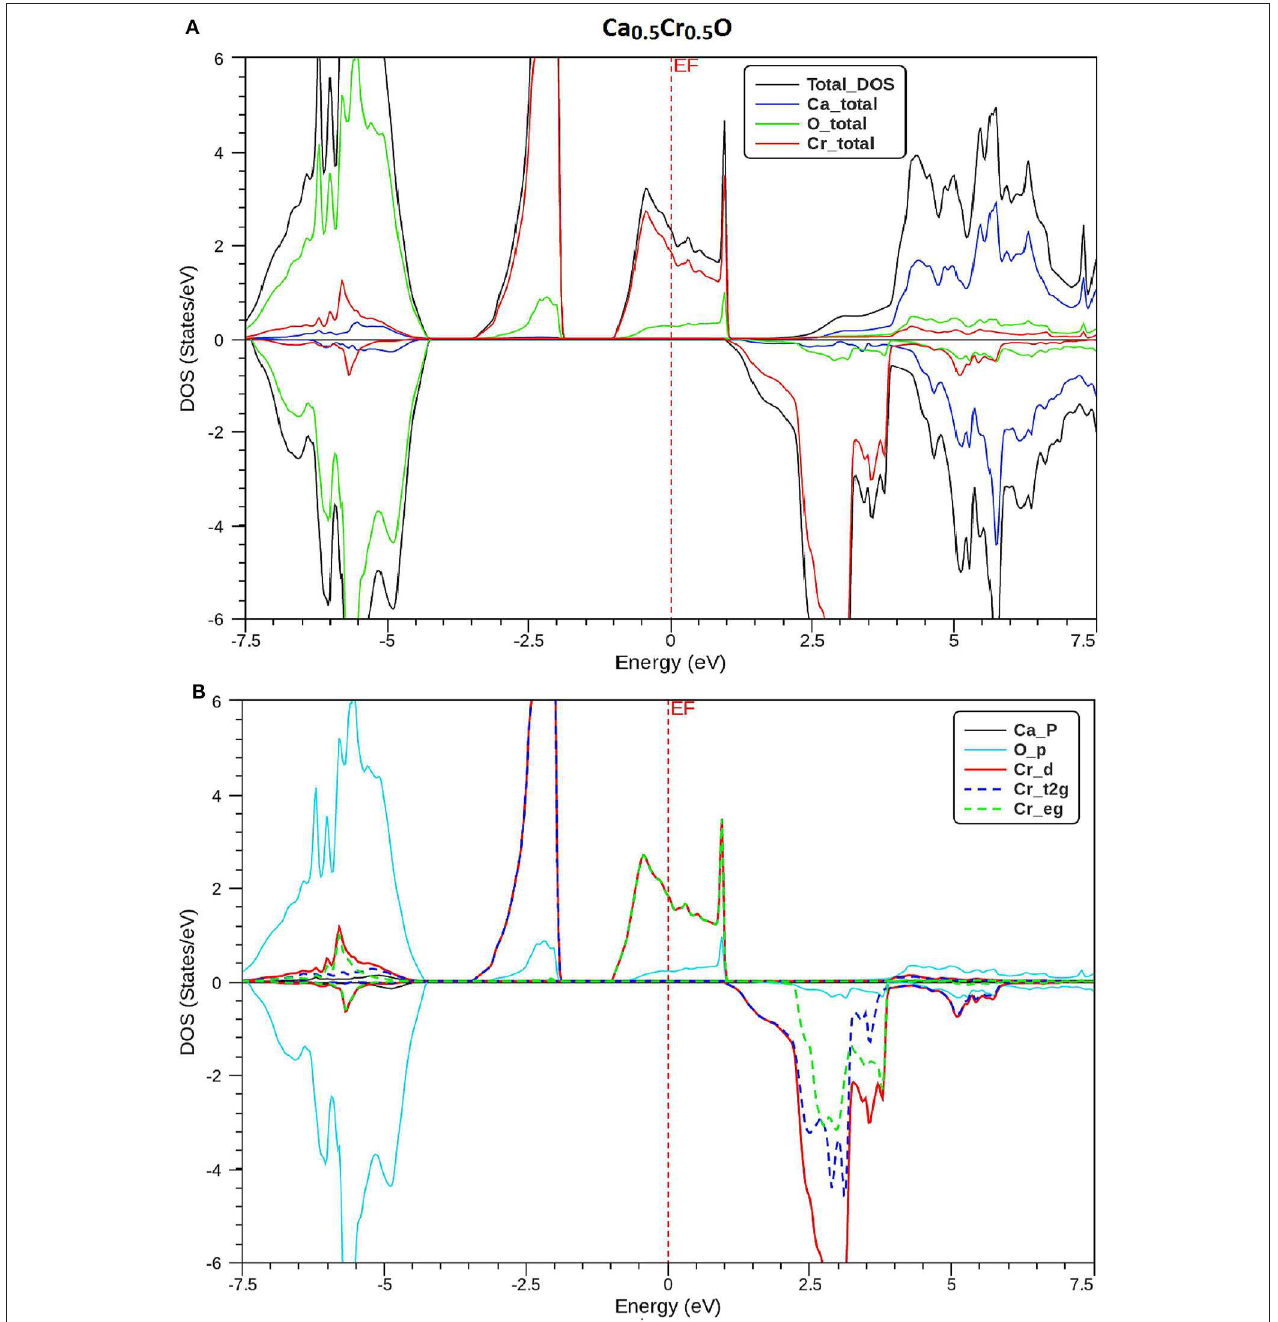
FIGURE 9 | Spin-polarized total and partial densities of states (DOS) of Ca 0.5 Cr 0.5 O. The Fermi level is set to zero ( vertical dotted line ). (A) Total DOS of Ca, Cr, and O and (B) DOS of p-Ca, p-O, d-Cr, t2g_d-Cr, and eg_d-Cr.